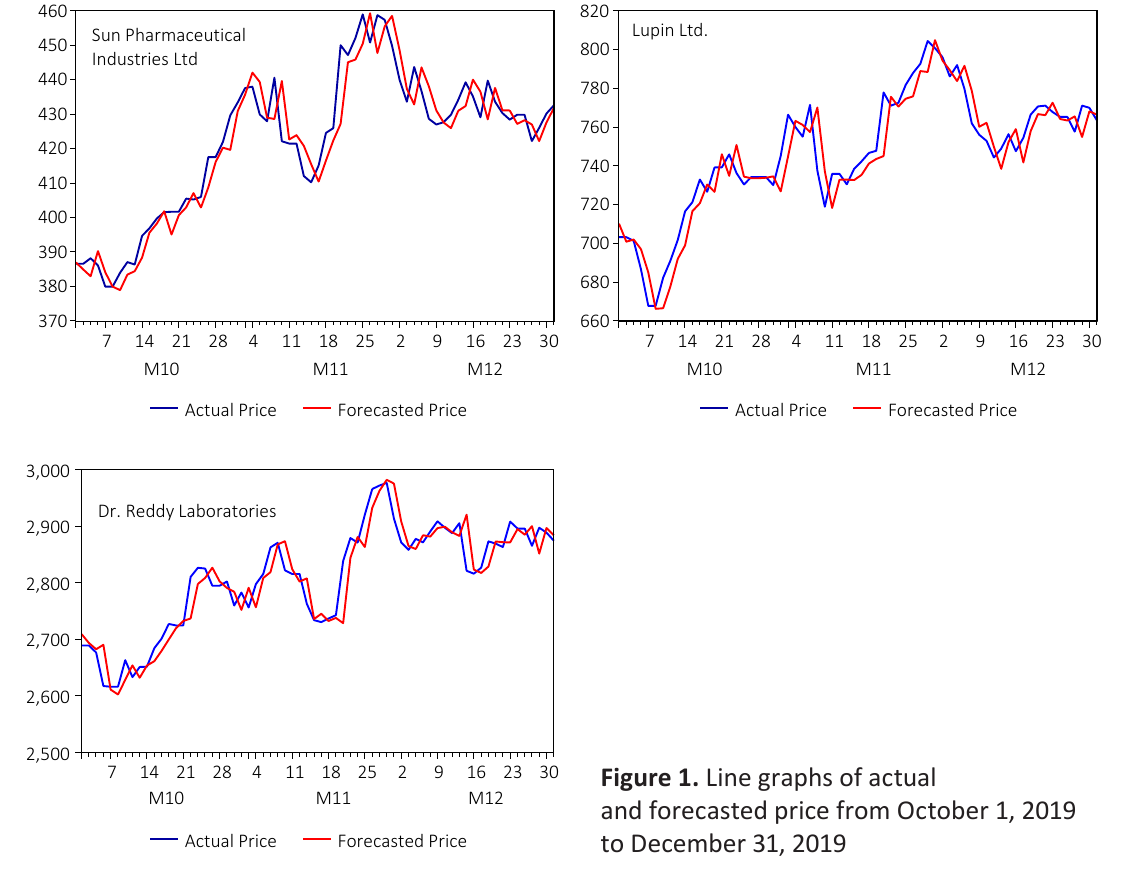
Figure 1. Line graphs of